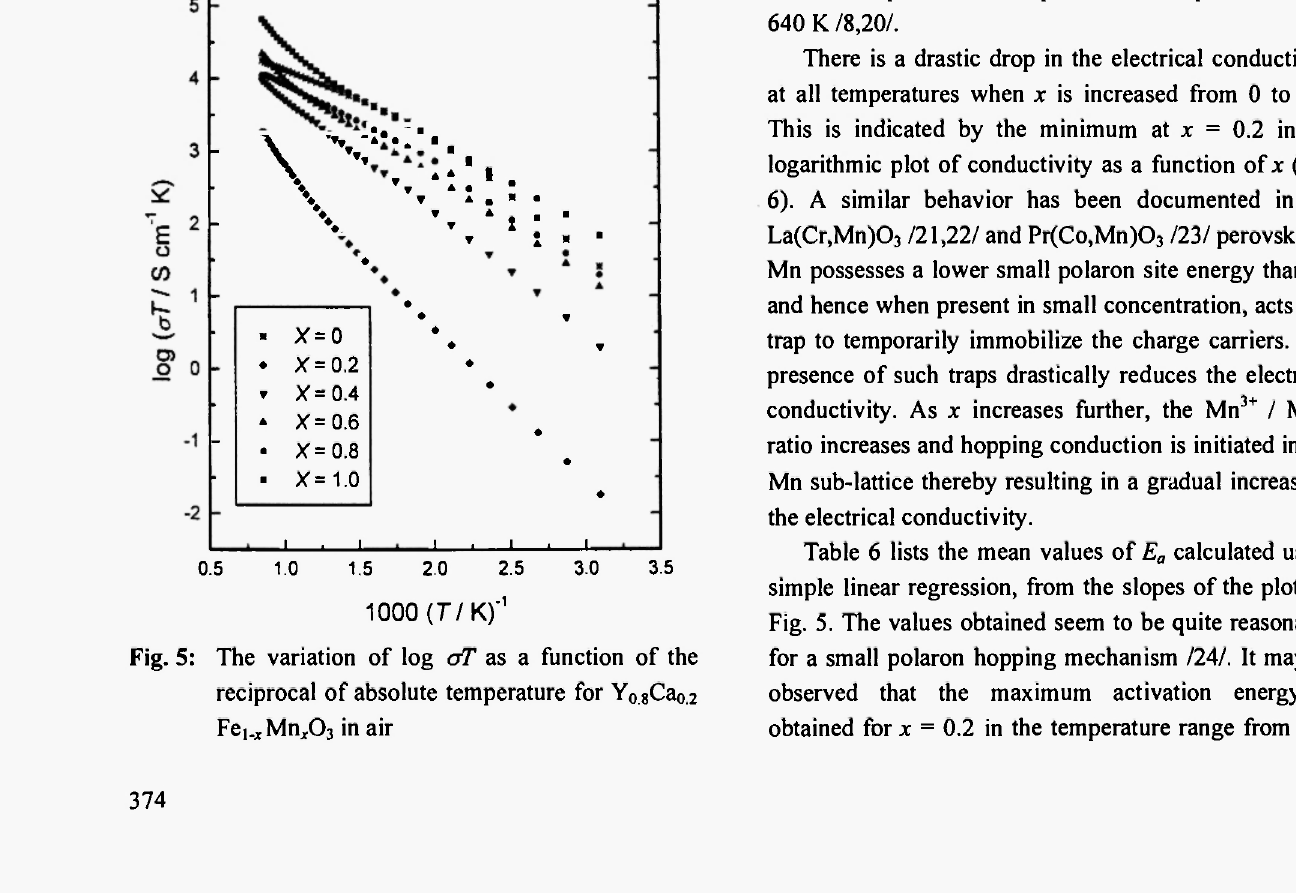
Fig. 5: The variation of log σΤ as a function of the reciprocal of absolute temperature for